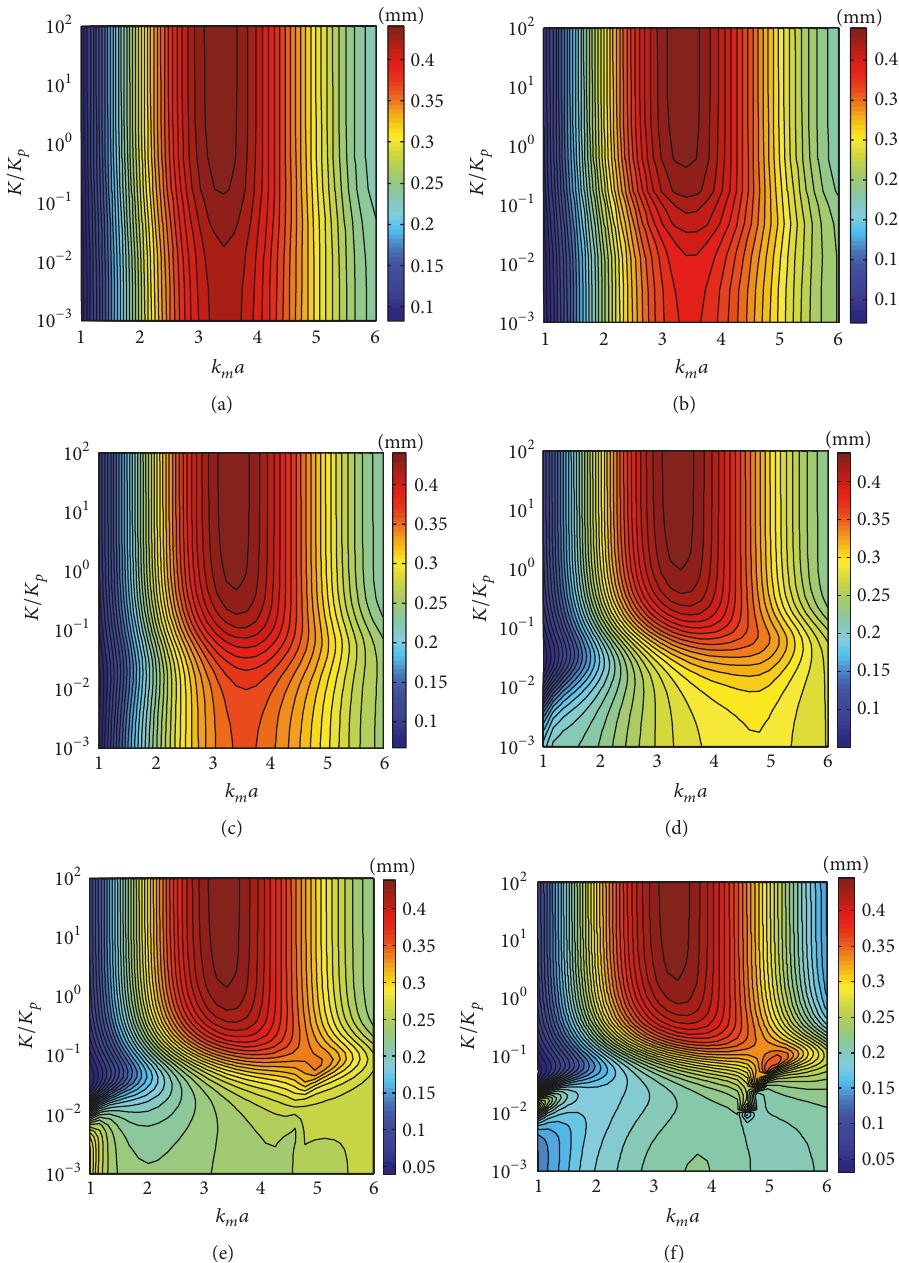
Figure 9: Contour plots of ⟨𝜎 𝑠 ⟩ changing with 𝑘 𝑚 𝑎 and 𝐾 at several 𝛽 s: (a) 𝛽 = 𝜋/6 , (b) 𝛽 = 𝜋/3 , (c) 𝛽 = 𝜋/2 , (d) 𝛽 = 𝜋 , (e) 𝛽 = 3/2𝜋 , and (f) 𝛽 = 2𝜋